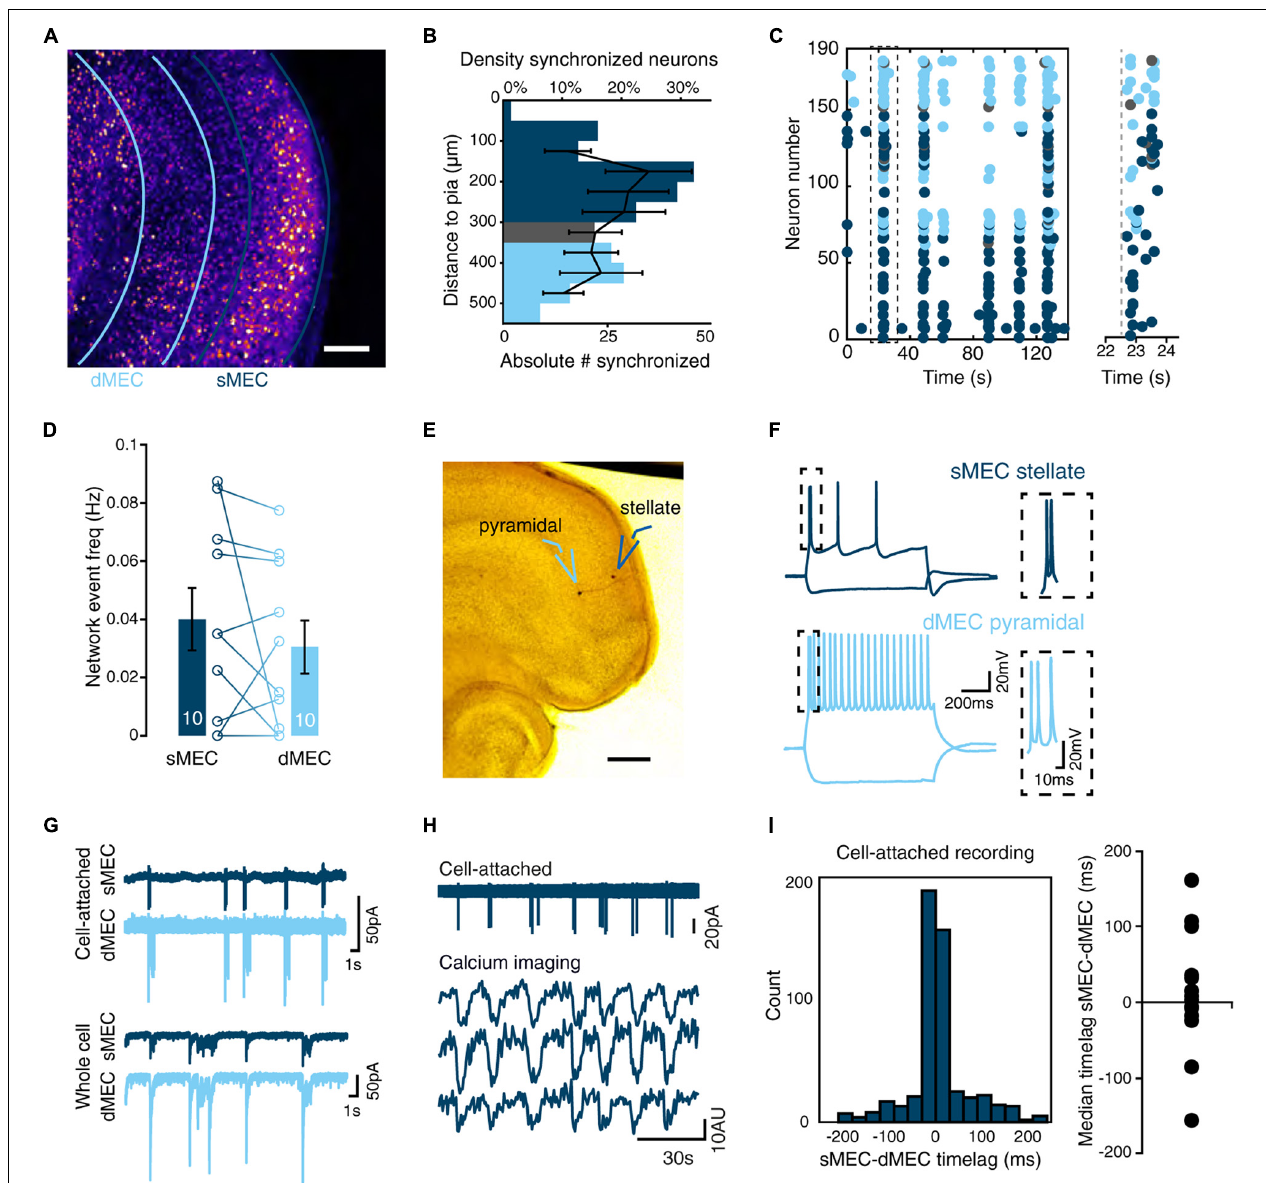
FIGURE 2 | Synchrony between deep and superficial layer networks in immature MEC. (A) Two-photon image of entire intact MEC loaded with Fura2-AM calcium dye. Scale bar 100 µ m. (B) Density of synchronized neurons (black lines, mean ± SEM) is not significantly different between deep (light-blue) and superficial layers (dark-blue) and intermediate (gray) layers [one-way ANOVA, F (7,69) = 0.76, p = 0.622]. Absolute number of synchronized neurons per distance bin indicated as bars. N is 8 slices. (C) Left: Representative raster plot of deep, superficial and intermediate layer MEC activity showing correlated synchrony across layers. Right: magnified view of the first network event indicated on the left by the dashed black box. Gray dashed line indicates onset of activity. (D) Quantification reveals no significant difference in frequency of synchronized network activity between deep and superficial networks [paired t (9) = 0.98, p = 0.353]. N shown in bars. (E) Representative biocytin-filled spiny stellate and deep layer pyramidal neuron taken from paired recordings in deep MEC (dMEC) and sMEC (scale bar 250 µ m). (F) Spike-profile of layer II stellate cell (top) and deep pyramidal neuron. (G) Example of cell-attached ( n = 14 pairs) and whole-cell recordings ( n = 6 pairs) showing synchrony of spike rates and synaptic inputs. (H) Example trace of a cell-attached recording in sMEC and simultaneously recorded calcium imaging traces from three neighboring neurons. (I) Histogram of the observed time lag for event onset using high temporal resolution cell-attached recordings ( n = 14 pairs) show correlated synchrony between deep and superficial layers (left) but no directionality (right, Wilcoxon signed rank test W = 64, p = 0.52) in immature MEC. Bar graphs represent the mean ± SEM. N shown in bars as the number of slices.